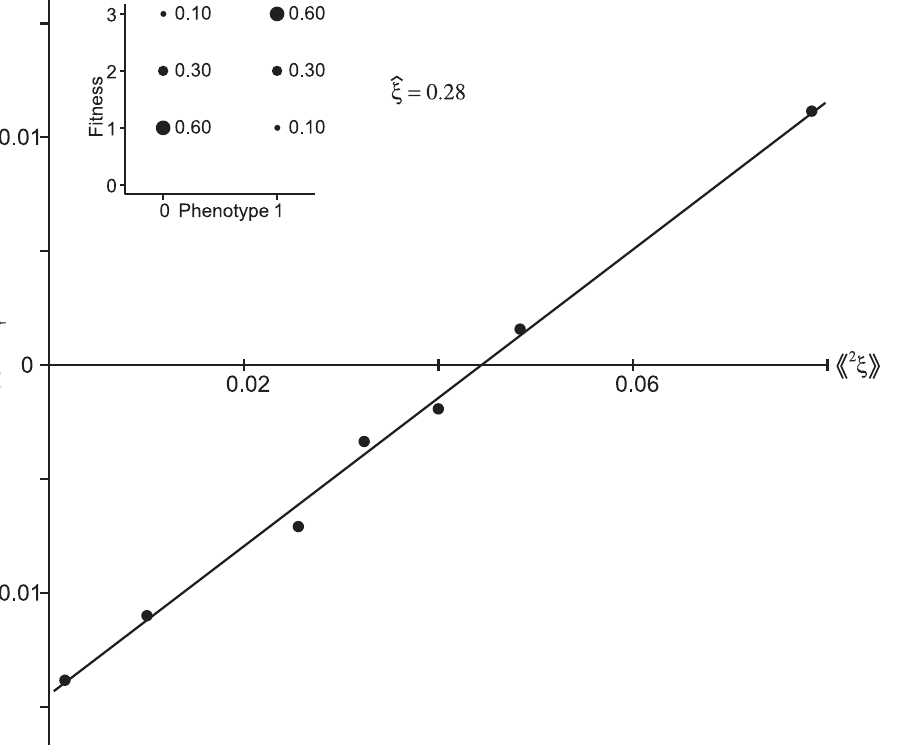
Figure 2. The influence of the variance in immigration rates, SS 2 j TT , on the expected change in mean phenotype. In this example, selection favors w ~ 1 (the fitness distributions are shown in the inset figure) while immigrants have w ~ 0 . The dots in the main figure represent the means of 10,000 runs of an individual based simulation with the same expected immigration rate ( b jj ~ 0 : 28 ) but different variances in j . In each case, the initial deme size was 50, and emigration was independent of both immigration and phenotype.